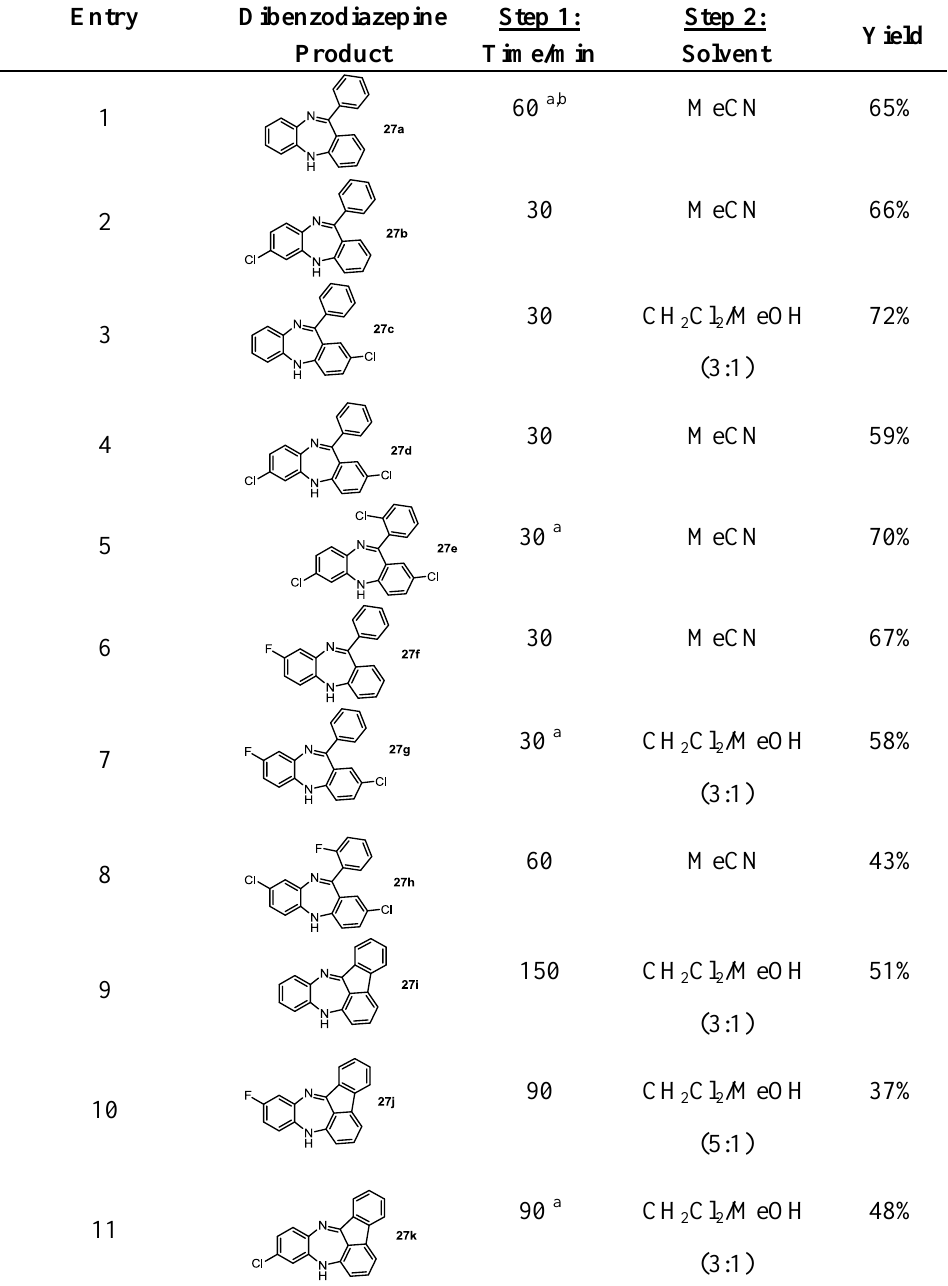
Table 1. Dibenzodiazepine derivatives